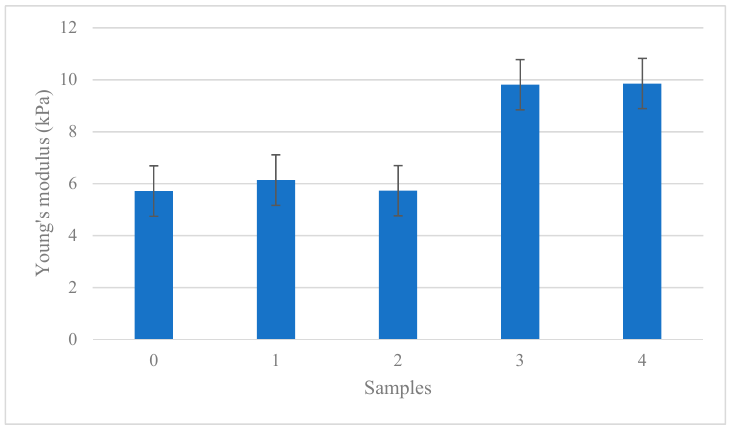
Figure 8. The elasticity effects of the antibacterial films by composition.